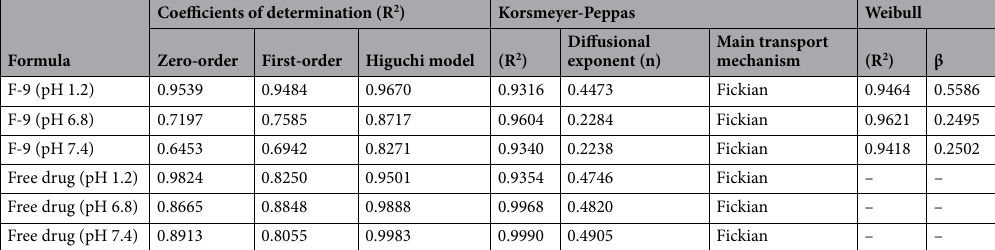
Table 3. Kinetic analysis of the percentage drug released and that diffused from ALL-loaded CS/STPP NPs (F-9) and pure ALL, respectively (see Table 2 for F-9).